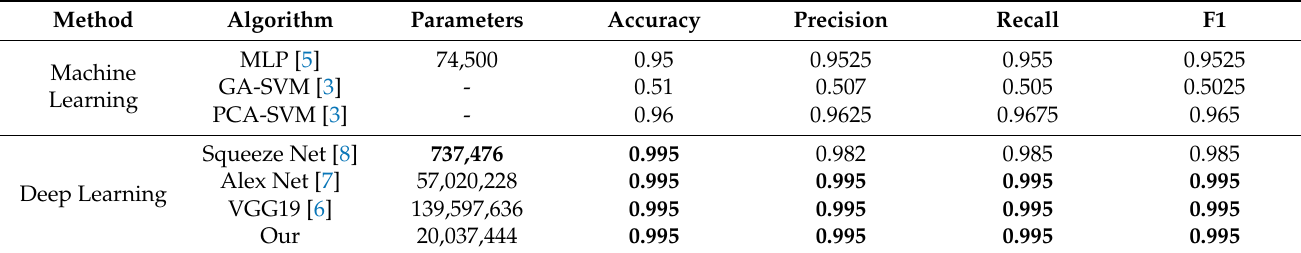
Table 4. Train noise-added data to compare test results with existing deep learning models.